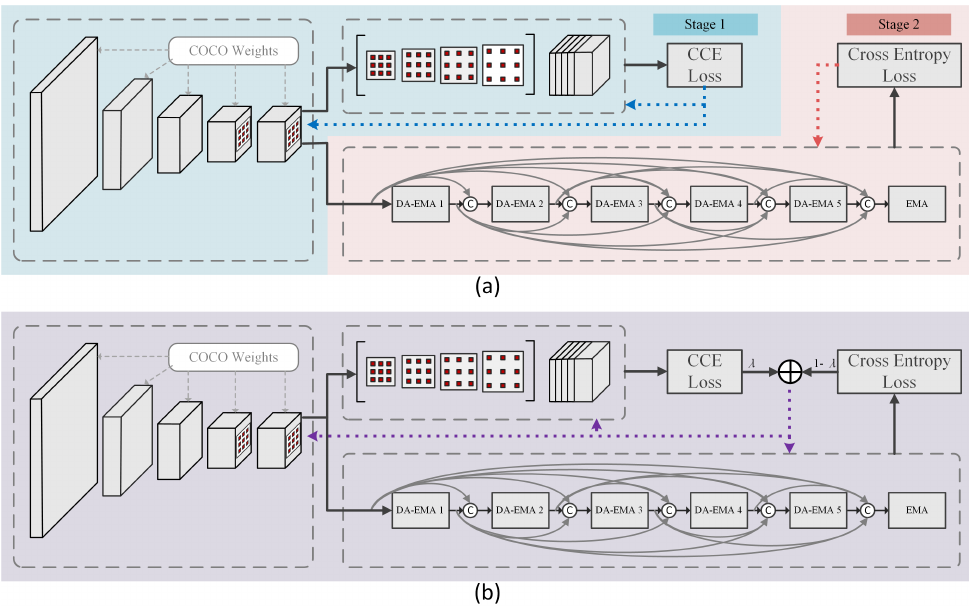
Figure 6. Two training methods implemented in this paper; dotted lines stand for back propagation.